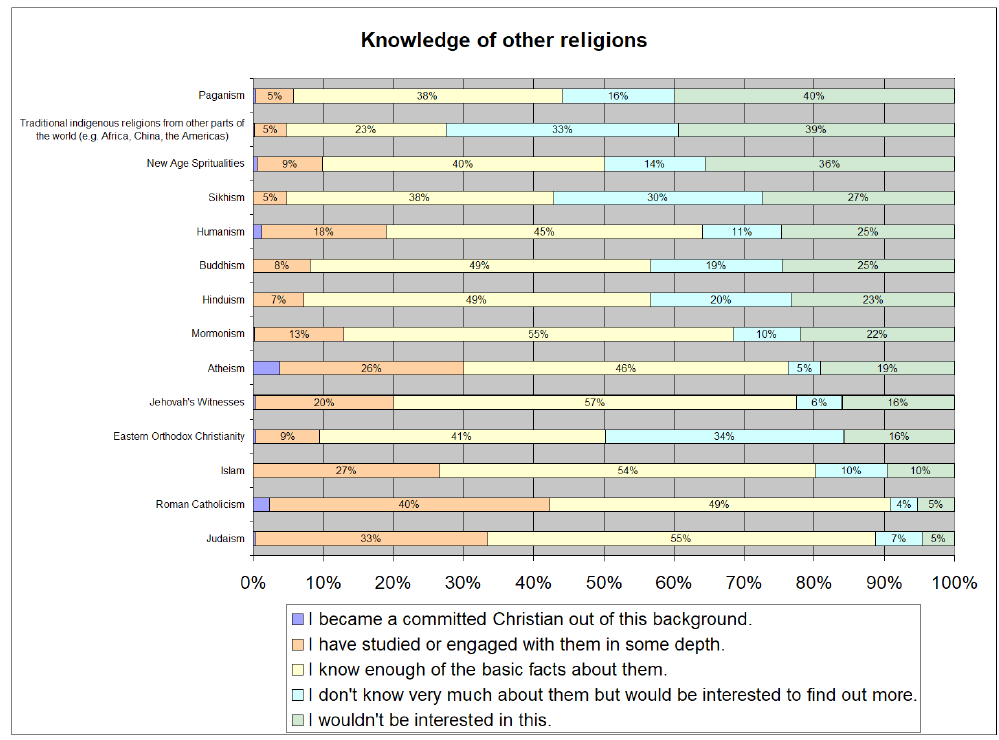
Evangelicals’ background knowledge of other